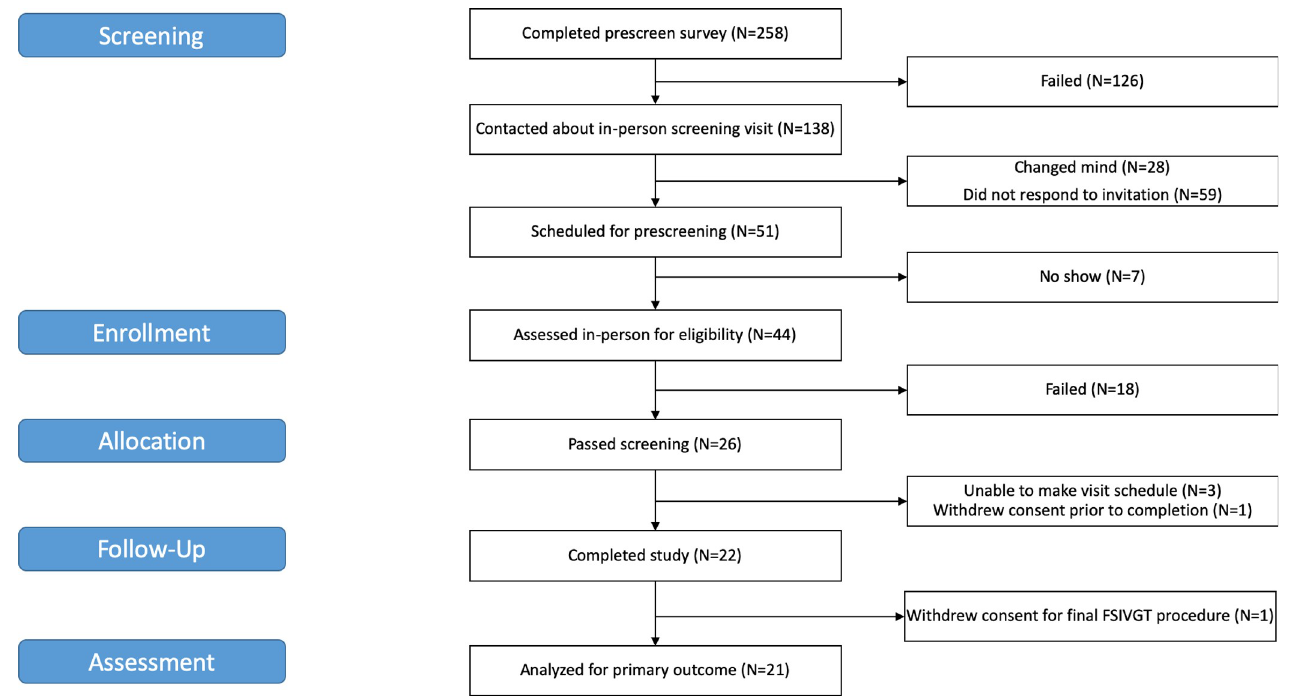
Fig 1. CONSORT flow diagram of medium chain triglyceride study participants.